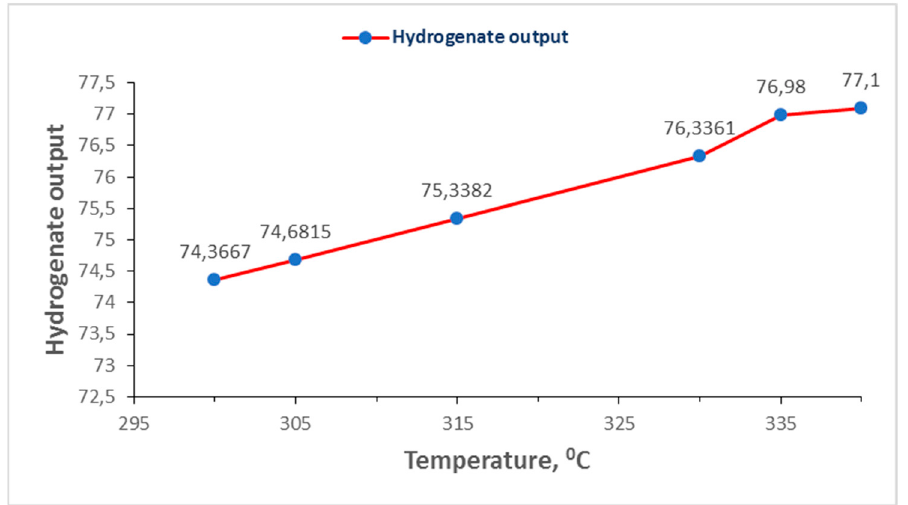
x —volume of raw ( ) y f x = for fixed ( Figure 2. Dependency graph y 1 = f 1 ( x 3 ) for fixed x 1 , x 2 , x 4 and x 5 ( x 1 —volume of raw materials, Figure 2. Dependency graph 1 1 1 3 80 m 3 /h, x 2 —pressure in R-1, 30 kg/cm 2 , x 4 —volumetric velocity, 3 h − 1 , x 5 —HCG circulation, x —pressure in в P-1, 30 kg/cm 2 , x —volumetric velocity, 3 h − 1 , x —HCG materials, 80 m 3 /h, 2 5 4 400 nm 3 circulation, 400 nm 3 ).